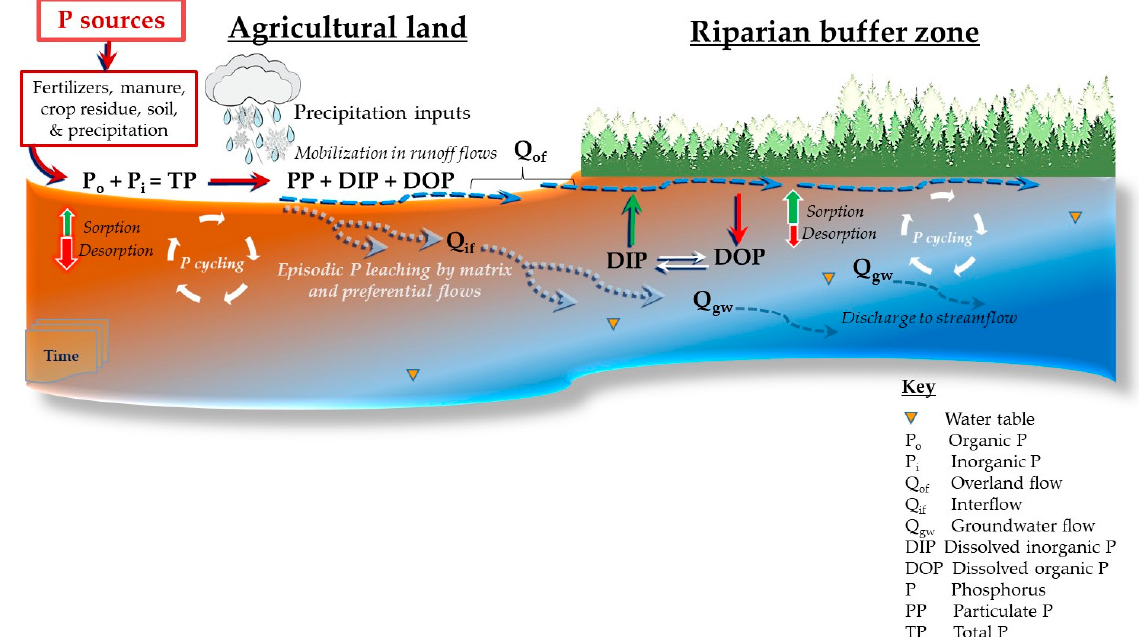
Figure 3. Conceptual diagram depicting hydro-biogeochemical and management factors driving phosphorus (P) fate and transport in cold climates (CCs). Dotted lines represent hydrologic flow pathways that transport P and other solutes. Red arrows represent P inputs into the system or P release via desorption reactions. Green arrows represent P removal via sorption reactions or metabolic uptake of dissolved inorganic P from solution. White arrows indicate biogeochemical processes affecting P bioavailability including pH fluctuations, redox reactions, organic matter cycling (mineralization), and hydrolysis of organic P that affect net P release and fluxes. Note presence of tile drains, stream bank erosion, and other aspects discussed in the text are omitted due to space limitations.